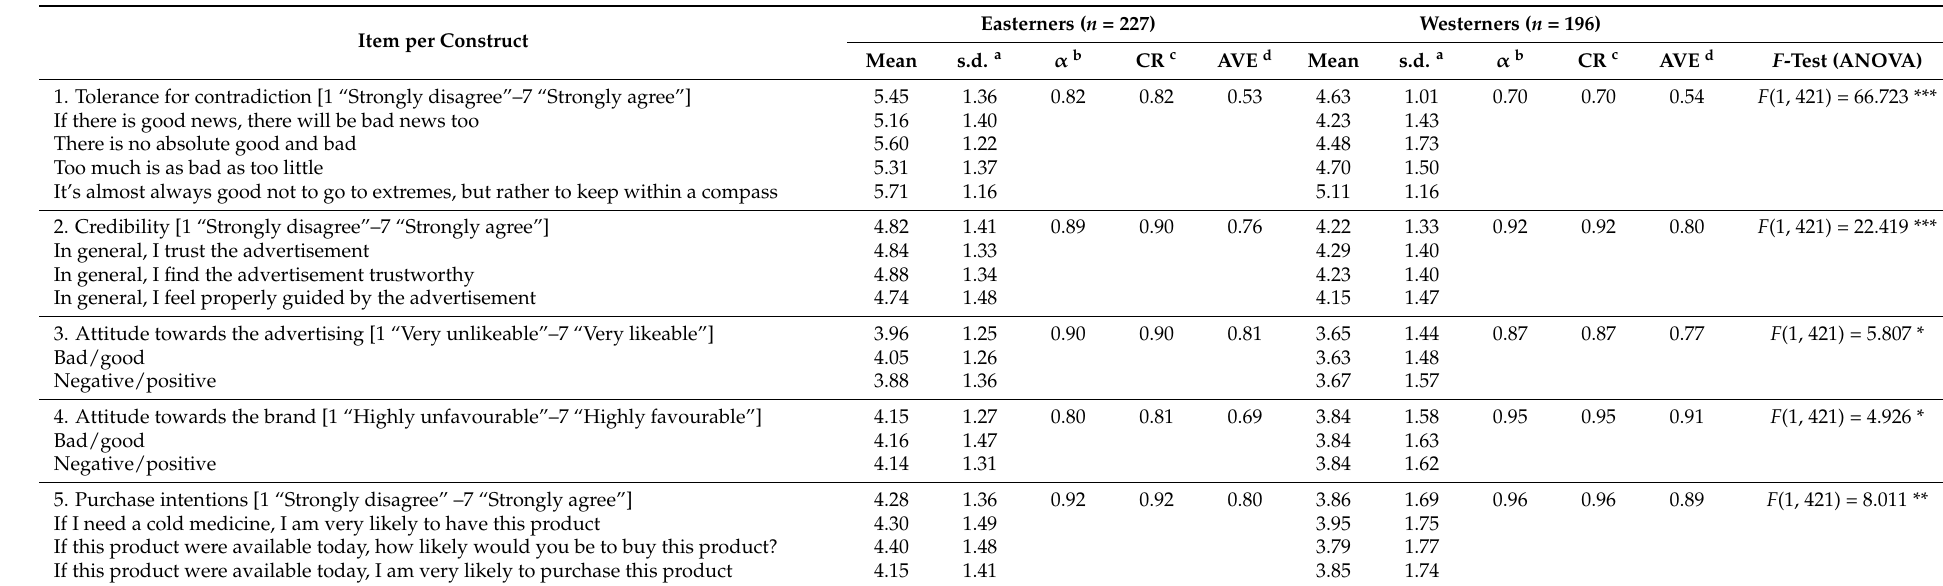
Table 3. Psychometric Properties of the Measures, correlations, and ANOVA